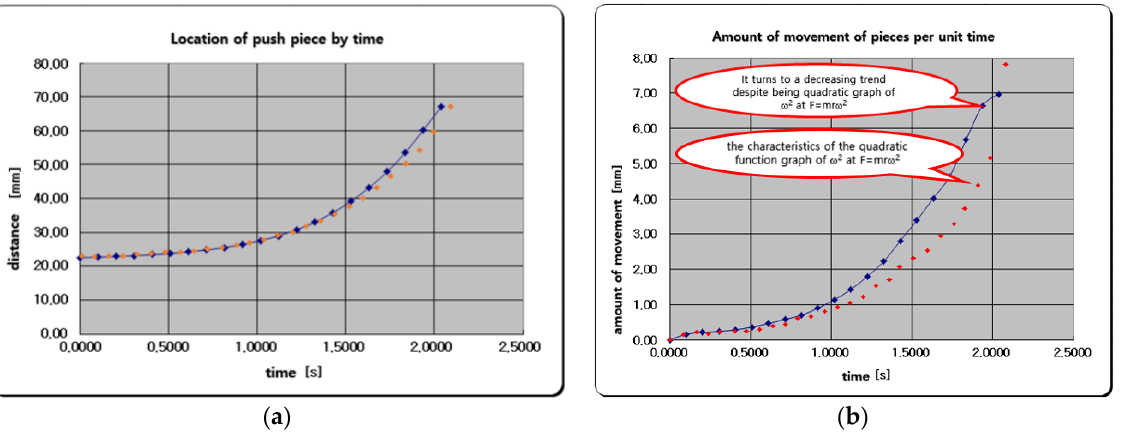
Figure 12. Behavior analysis when the normal (orange) and spline (blue) of the plate rail was 28 degrees during acceleration; ( a ) Location of piece over time; ( b ) Amount of movement of pieces per unit time.